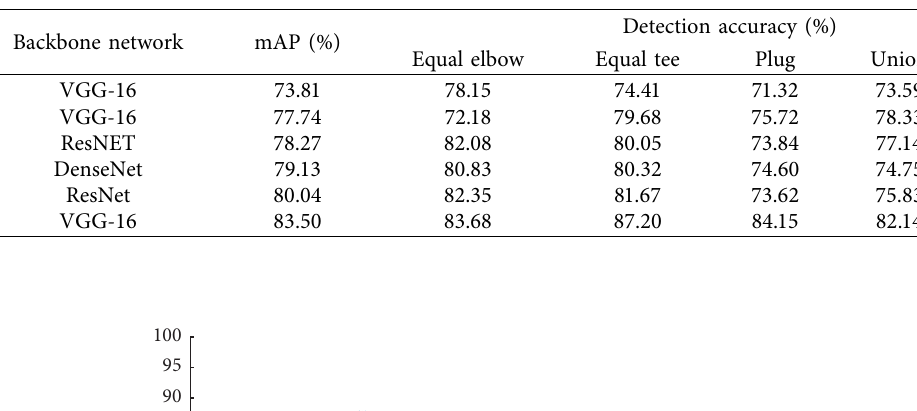
Figure 7: Flowchart of workpiece type detection. Table 1: Comparison of evaluation parameters of three target detection methods.